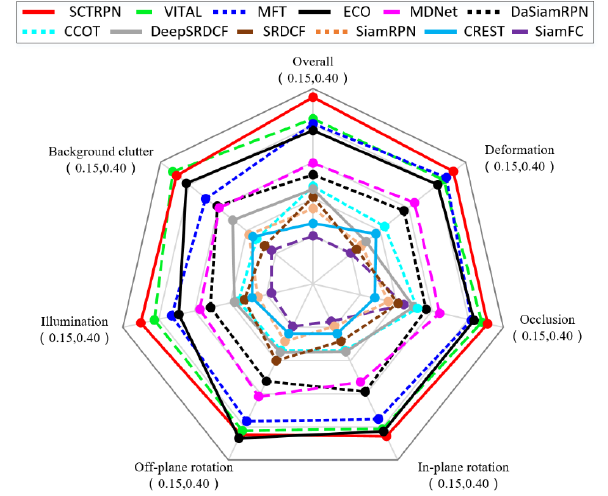
Figure 11. Attribute-based evaluation of the trackers. The experimental results show the validation of six attributes including deformation, occlusion, in-plane rotation, off-plane rotation, illumination change, and background clutter. The numbers under the name represent the range of the attributes respectively.